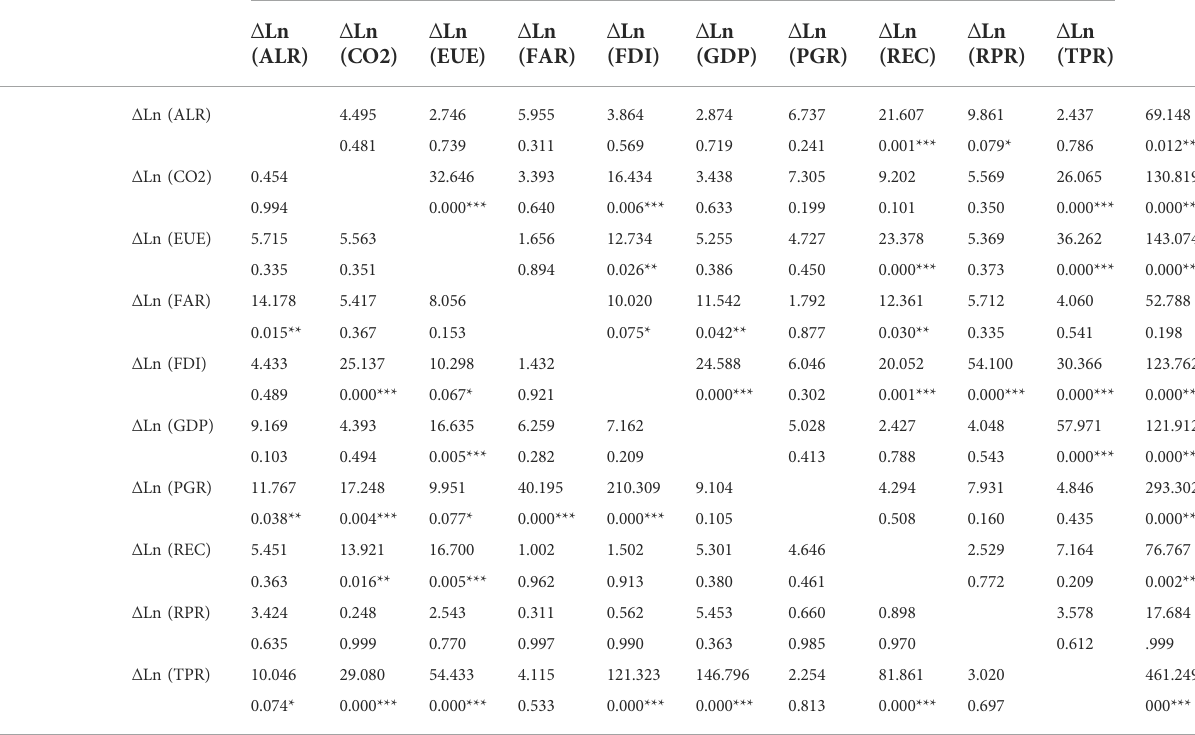
TABLE 8 Pairwise Granger causality